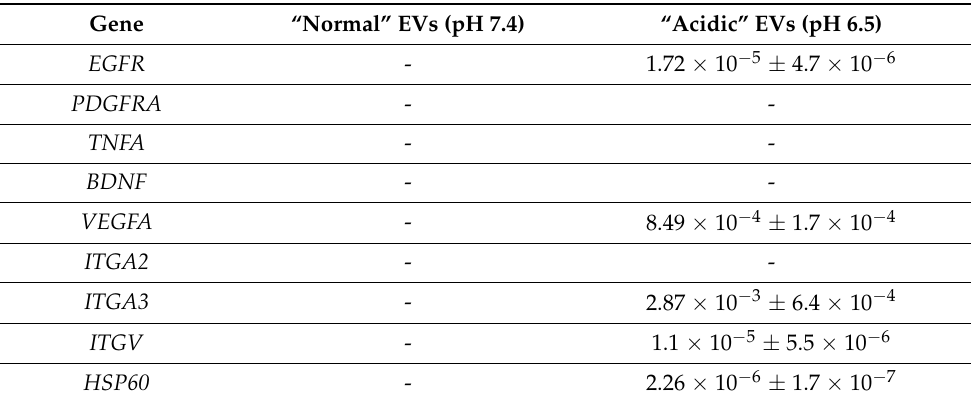
Table 1. Analysis of mRNA contained in EVs derived from the mel P cells cultivated at pH 6.5 and pH 7.4. Expression is normalized to the mRNA level ± SEM ( n =